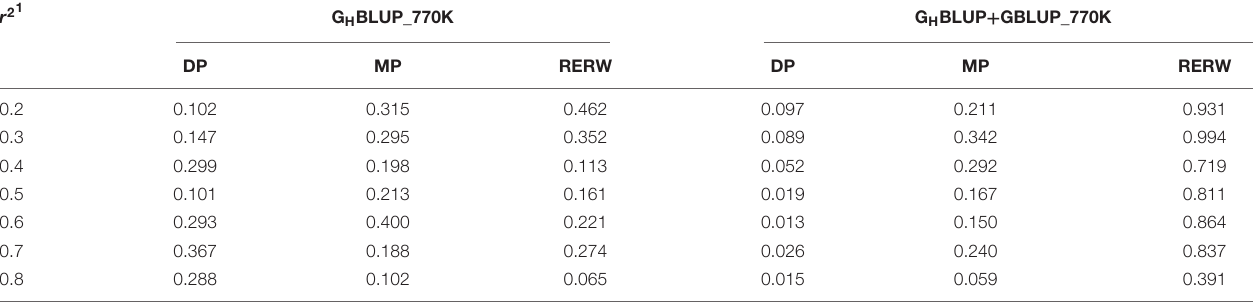
TABLE 4 | P -values of Hotelling’s t -test comparing the prediction accuracy obtained with the individual SNP and haploblock approaches using 770K data. r 21 G H BLUP_770K